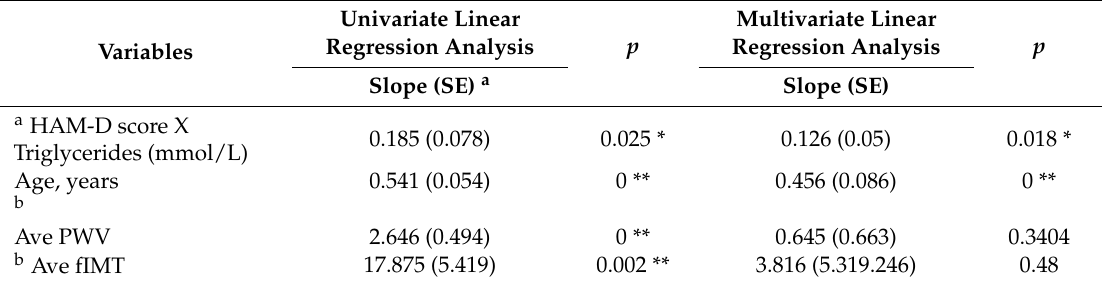
Table 3. Univariate and multivariate linear regression analyses using Framingham risk score (FRS) as dependent variable in medicated patients with major depressive disorder